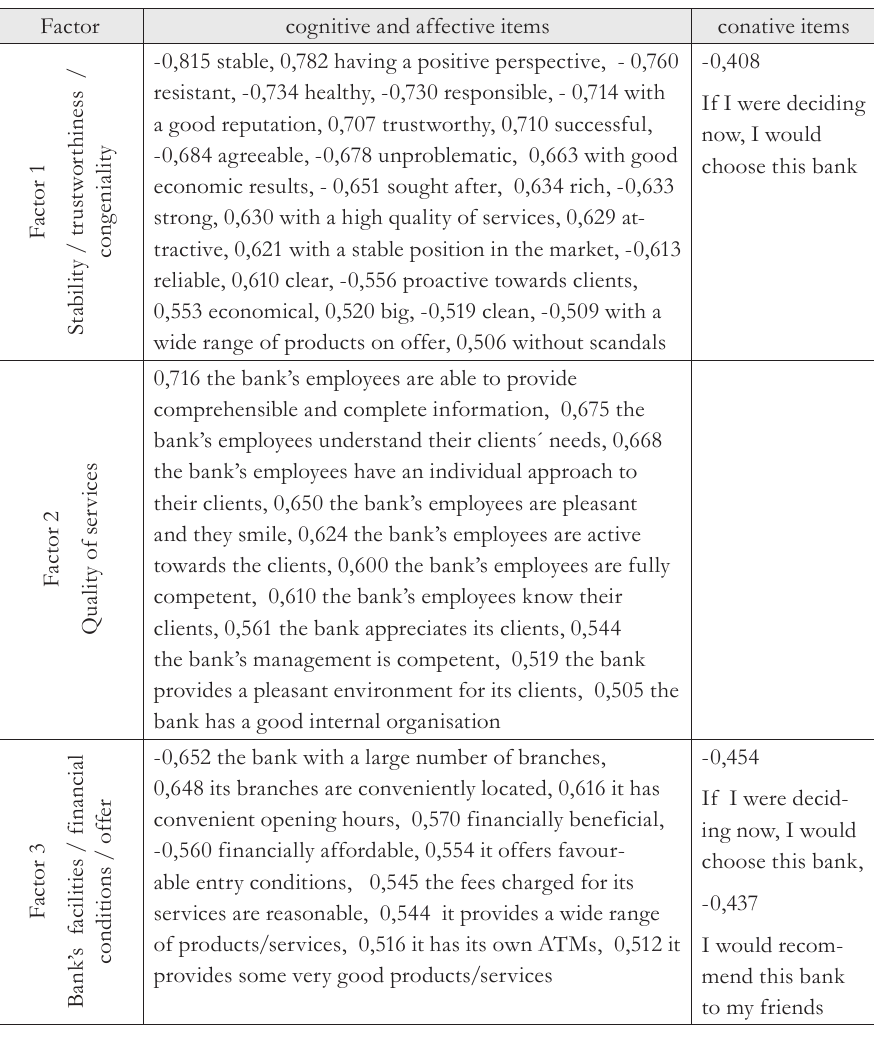
Tab. 6 - Bank 2: A description of the content of the extracted factors. Source: author. Factor cognitive and affective items conative